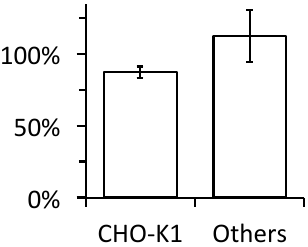
Figure 8. Absence of impact of H 2 O 2 on the respiration is common to di ff erent cells. Oxygen consumption rate after H 2 O 2 had been exhausted is expressed in % of the reference rate for cells exposed to 500 µ M H 2 O 2 ; values expressed as mean ± SD; CHO-K1: 21 preparations of CHO-K1 with cell density ranging from 0.35 to 2.08 × 10 e 6 cells per mL. Others: 7 preparations of the cell lines used in Figure 5b (one value per cell line cell and density ranging from 0.86 to 3 × 10 6 cells per mL).